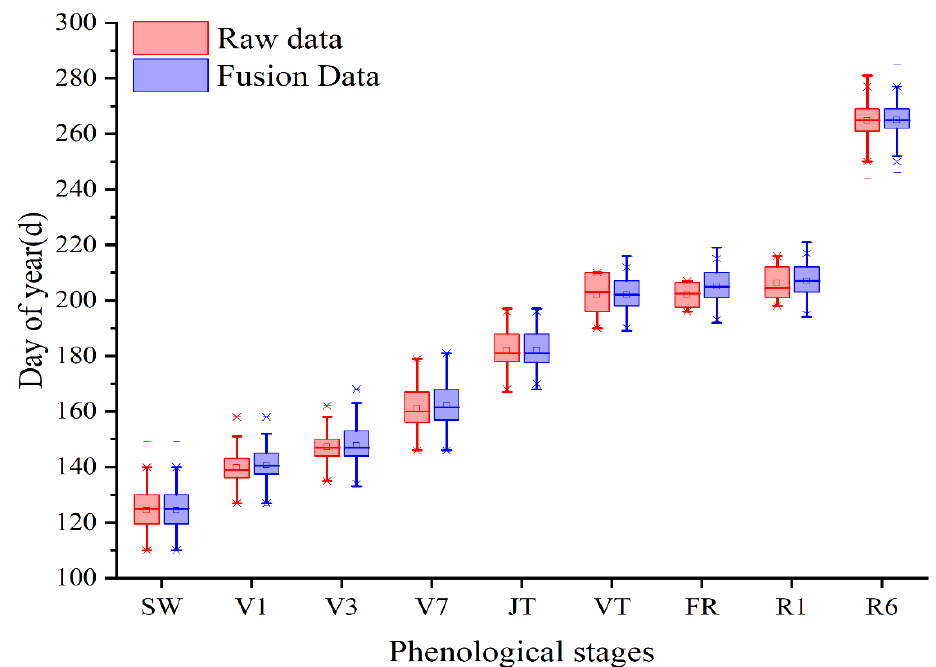
Figure 2. Comparison of raw and fused data for each phenological